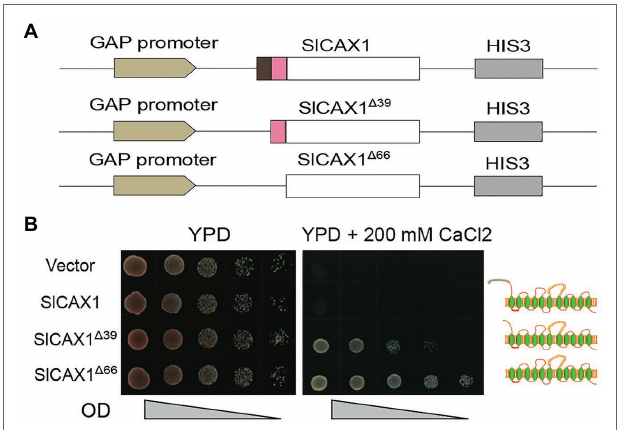
FIGURE 4 | Amino acid residues before the first TM domain of SlCAX1 negatively regulate the Ca 2+ transporting ability of the antiporter. (A) Schematics of the vectors used to express different truncated versions of SlCAX1 . (B) SlCAX1 , SlCAX1 Δ 39 and SlCAX1 Δ 66 were expressed in yeast strain K667. The cultures were diluted 10, 100, 1,000, and 10,000 times from OD 1.0, respectively, and an equal amount of sample was pipetted onto YPD medium with or without 200 mM CaCl 2 . The yeast cells were cultured at 30 ° C for 3